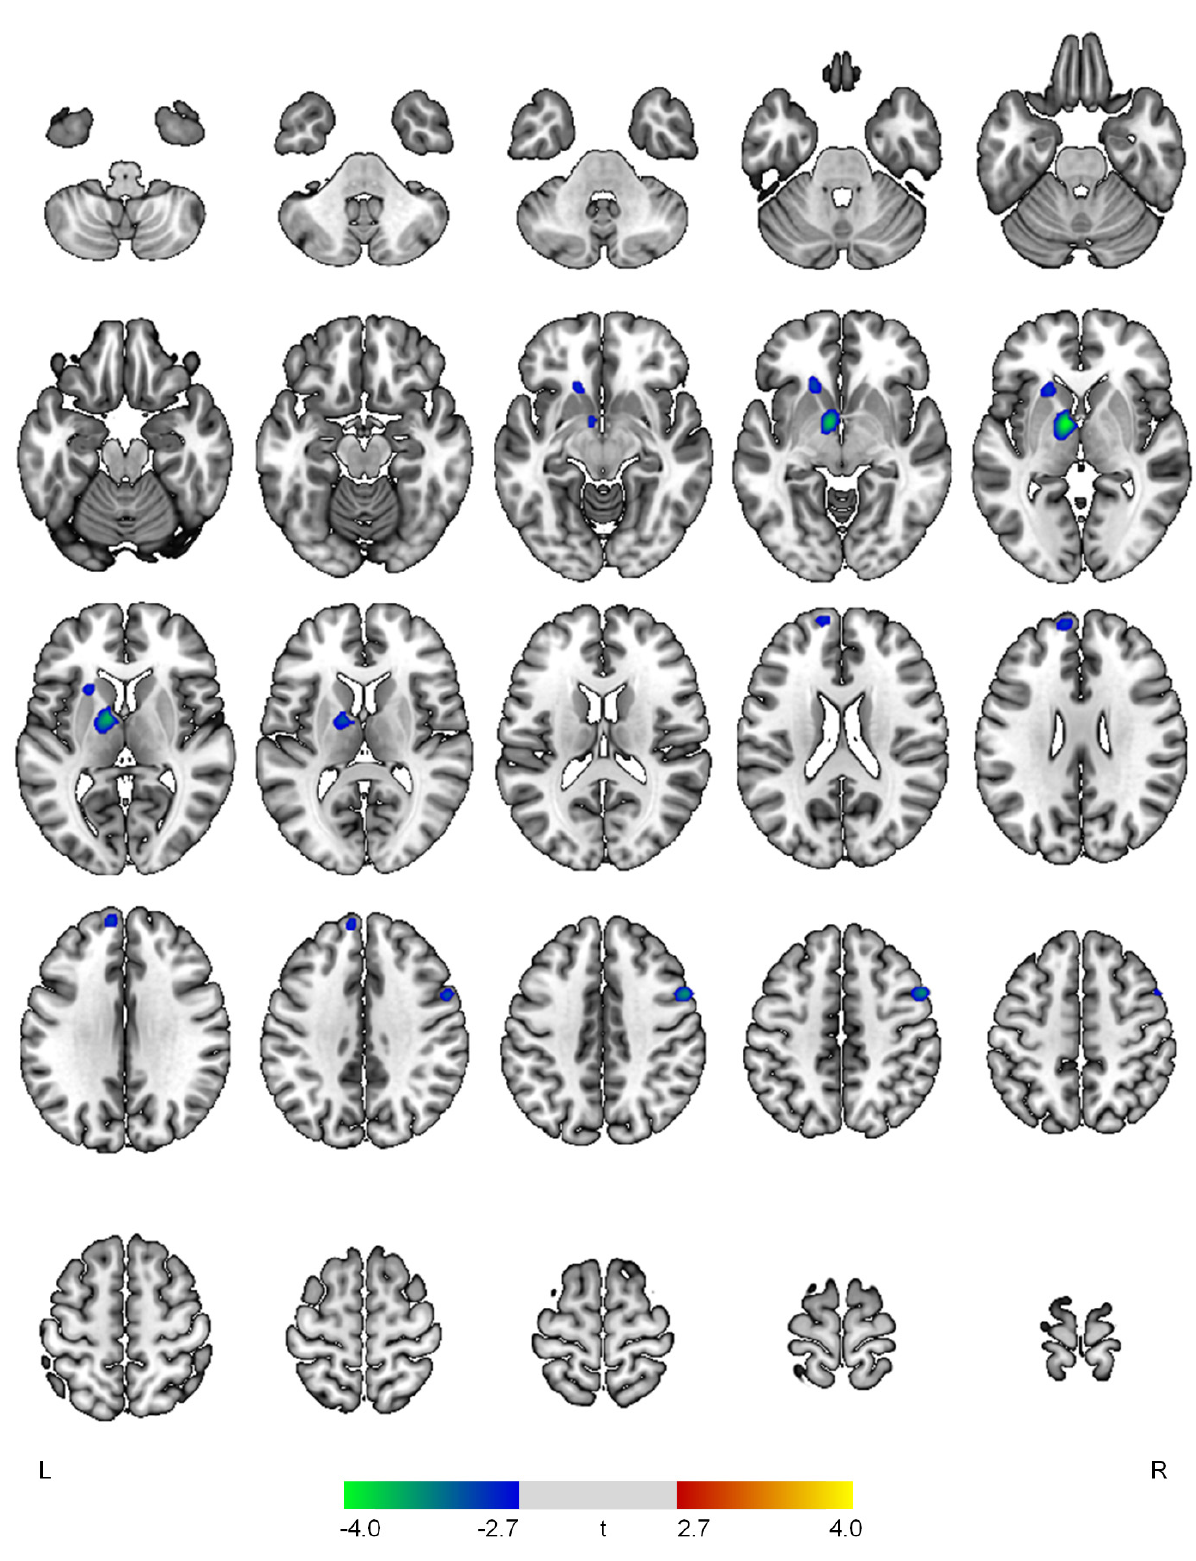
Figure 1. Positive (red-yellow) or negative (blue-green) correlations between regional cerebral blood flow and the affective domain in patients with early Alzheimer’s disease. The color bar represents t values at each voxel. L —left; R —right.